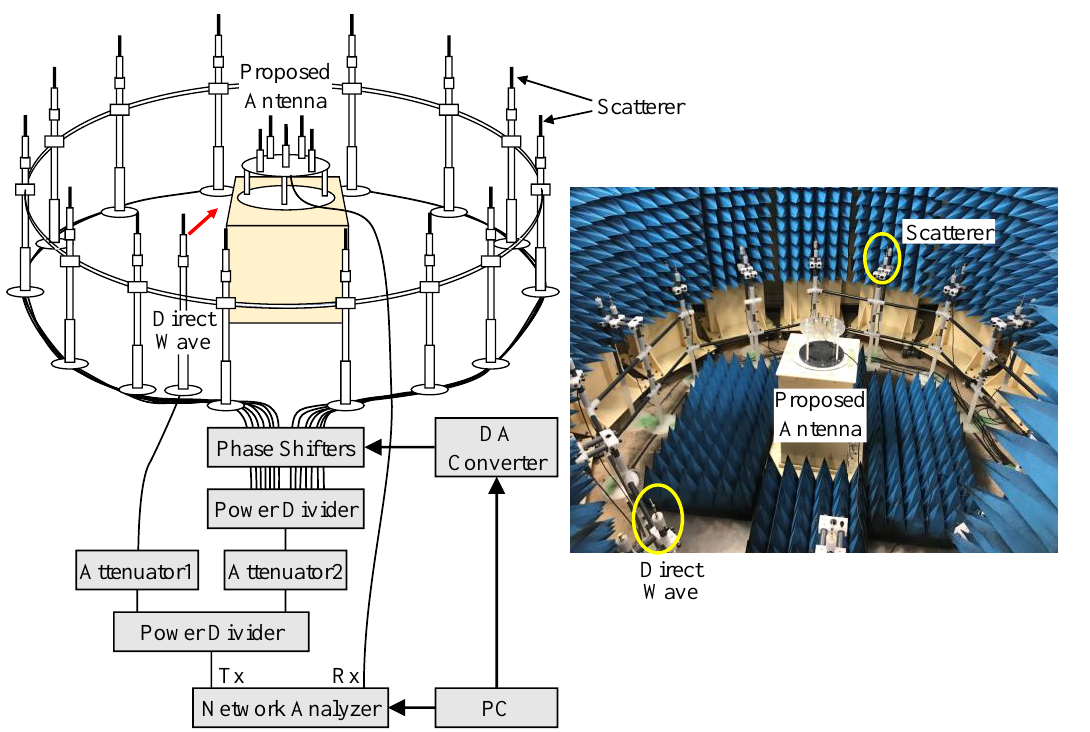
Figure 20. Two-dimensional fading emulator to realize a Rice propagation environment.